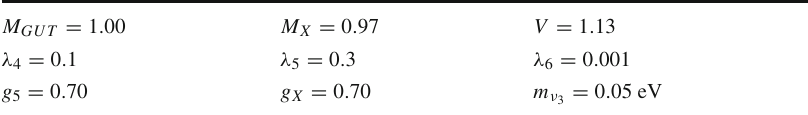
predictions of an FSU(5) point that yields (cid:3) a μ = 150 × 10 −